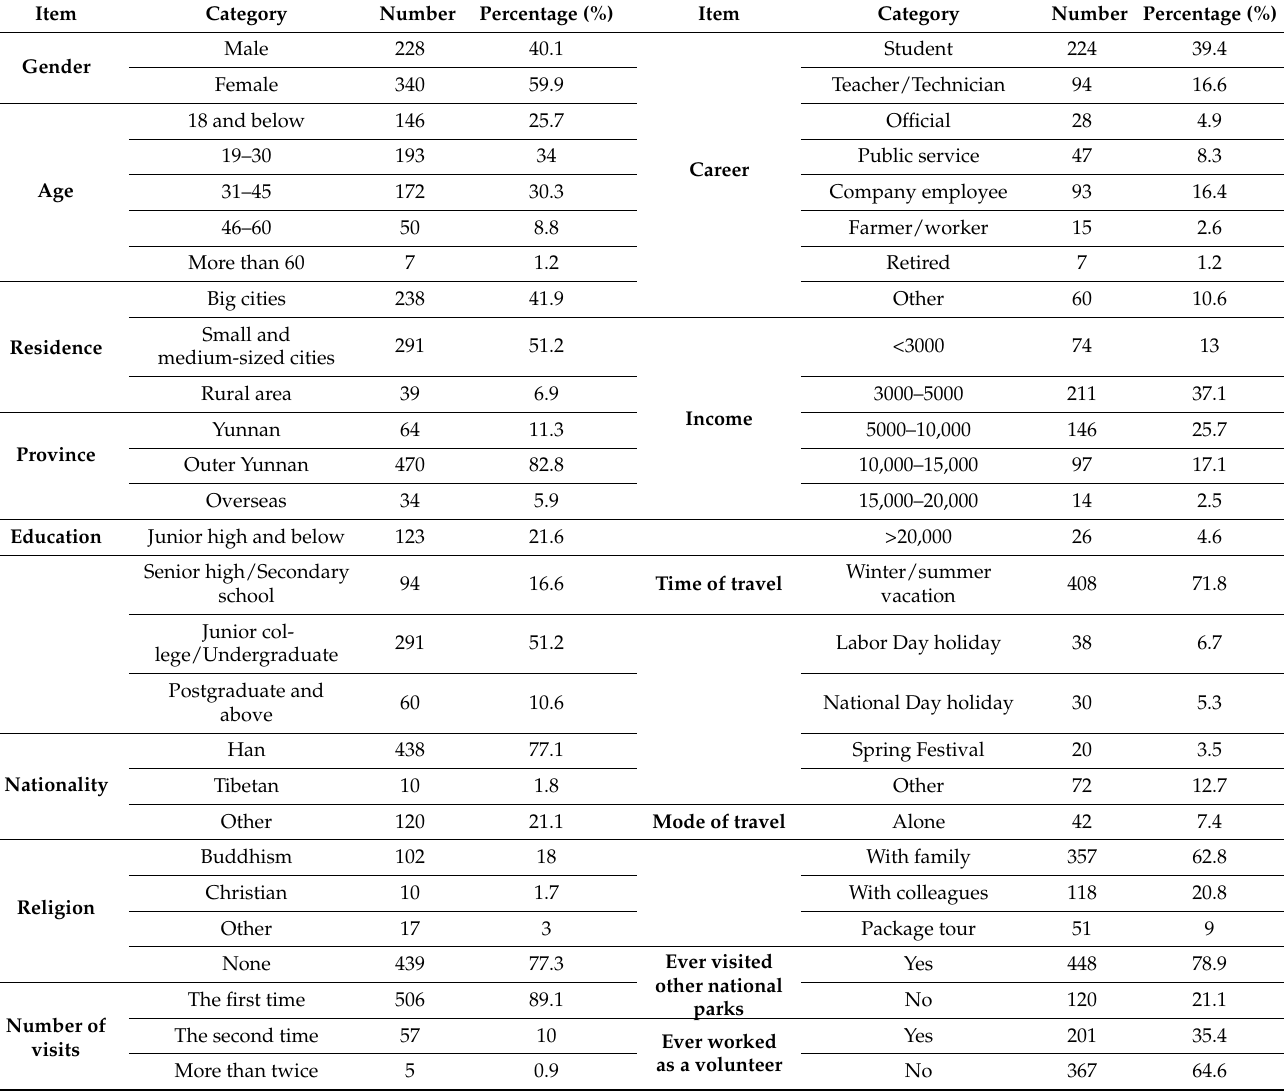
Table 2. Sample demographic